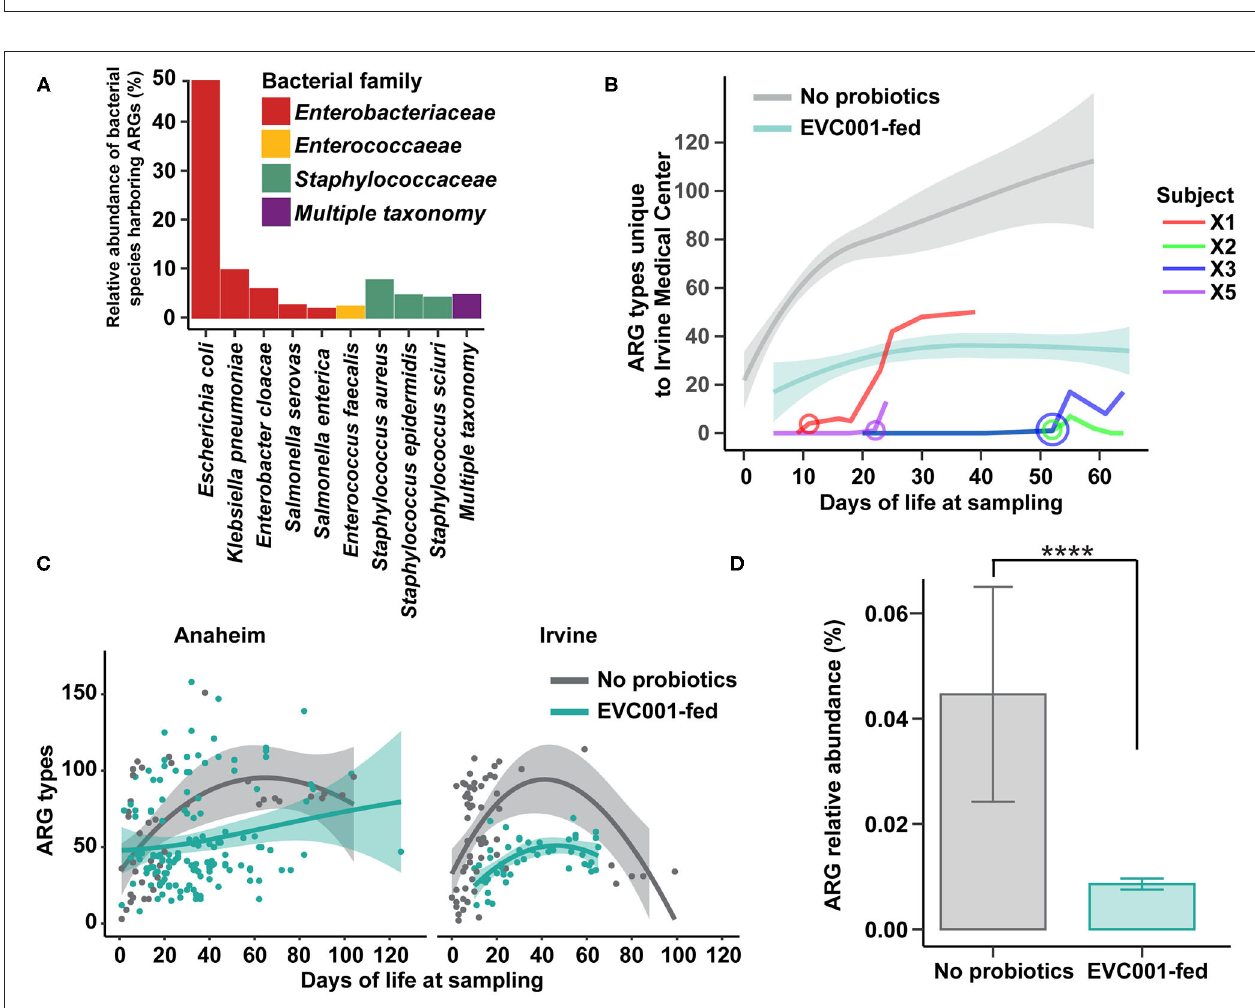
FIGURE 5 | Antibiotic resistant bacteria and antibiotic resistance genes are reduced among infants fed B. infantis EVC001, irrespective of hospital location. (A) The relative proportion of antibiotic resistance genes identified among taxa in fecal metagenomes. Nearly all ARGs could be assigned to Enterobacteriaceae (red), Enterococcaceae (yellow), or Staphylococcaceae (green), though some could not be confidently assigned to one organism (purple). (B) Infants transferred between hospitals participating in this study demonstrated rapid colonization by bacteria harboring hospital-specific ARGs after their transfer date (circle, age in days at transfer). All four transferred infants were assigned to the feeding protocol including B. infantis EVC001, and the amount of hospital-specific ARGs trended lower and similar to other infants in the unit that received B. infantis EVC001 (teal line, confidence intervals), relative to infants who did not receive the probiotic (gray line, confidence intervals). (C) Infants at the two hospitals developed similar patterns of ARG colonization, with more than 100 different unique ARGs detected. Infants acquired ARGs throughout their stay, though infants fed B. infantis EVC001 tended to acquire fewer unique ARGs (teal), relative to infants who did not receive the probiotic (gray). (D) Samples from infants fed B. infantis EVC001 also exhibited a lower overall relative abundance of ARGs (teal), as a proportion of their microbiome, compared to samples from infants who did not receive the probiotic (gray) ( P values indicated by asterisks, **** P < 0.0001